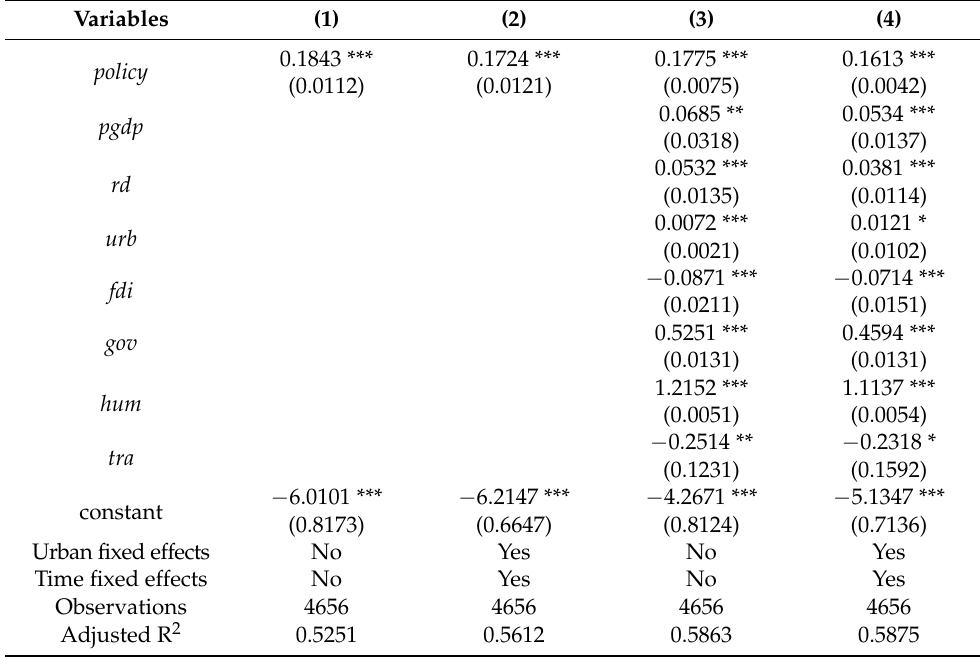
Table 3. Baseline model regression